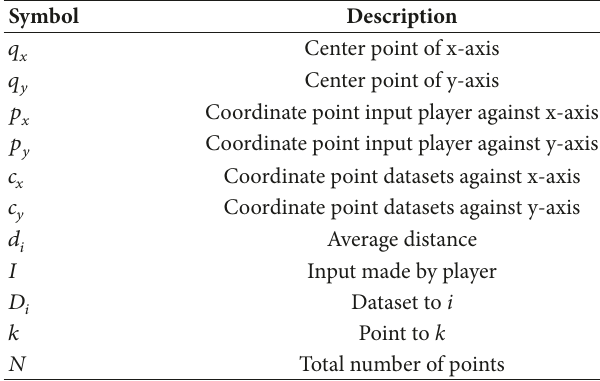
Table 8: Description of Formula